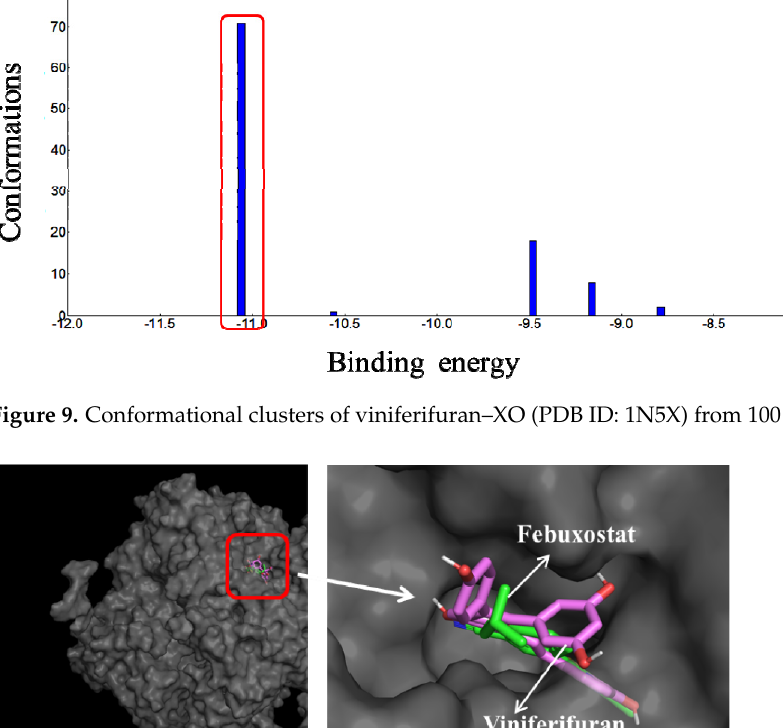
Figure 9. Conformational clusters of viniferifuran–XO (PDB ID: 1N5X) from 100 docking runs.